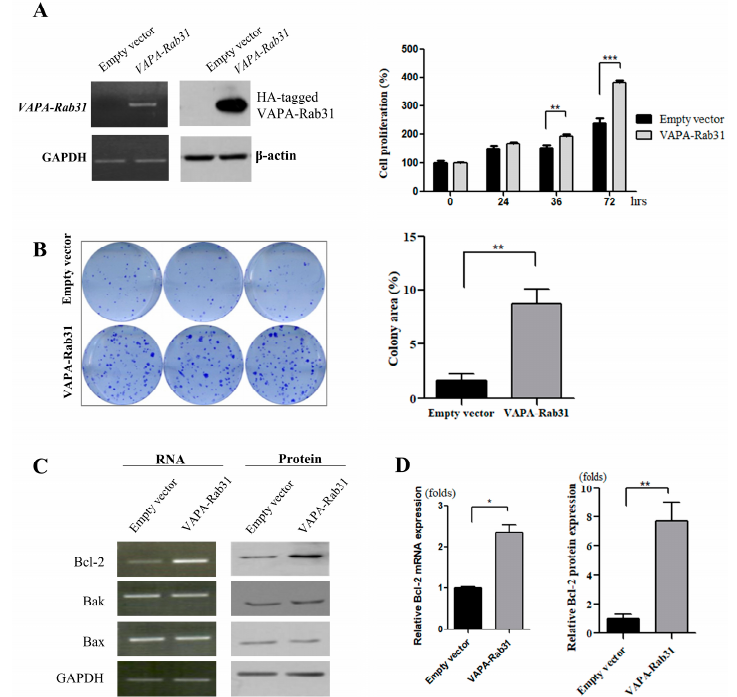
Figure 2. Overexpression of VAPA-Rab31 fusion increases proliferation, colony forming activity, and Bcl-2 expression. ( A ) Lentivirus-mediated overexpression of VAPA-RAb31 in Beas-2B cells was confirmed by RT-PCR and immunoblot assay detecting HA tag. Glyceraldehyde-3-phosphate dehydrogenase (GAPDH) and β -actin was used as control. Bar graphs indicated the relative cell numbers as the mean percentage (± standard error, SE) at the indicated time; the experiments were performed in triplicates. (** p < 0.01, *** p < 0.005) ( B ) VAPA-Rab31 -overexpressing cells and control cells were cultured to compare colony forming activity as demonstrated as representative data. Bar graphs compare the area of colonies that measured using ImageJ software. Data are expressed as means ± SE from three independent experiments and a significant result is marked with ** ( p value < 0.01). ( C ) Expression of Bcl-2, Bak and Bax were examined by RT-PCR and Western blotting. ( D ) The graph indicates the fold change of Bcl-2 expression relative to the expression in control cells. Statistical differences are marked with * ( p < 0.05), and ** ( p < 0.01), respectively. 2.3. VAPA-Rab31 Fusion Induces Resistance to Apoptosis To examine the effect of VAPA-Rab31 on apoptosis, the apoptotic markers were compared after induction of apoptosis through bortezomib treatment. Cell cycle analysis revealed that the proportion of sub-G1 phase cells was smaller in the VAPA-Rab31 -overexpressing cells than in the control cells (Figure 3A). The cleaved PARP and active Caspase-3 were strongly induced in the control cells after bortezomib treatment. However, the cleavage of PARP and the active form of Caspase-3 in VAPA-Rab31-overexpressing cells was not induced as much as the control cells after bortezomib treatment indicating reduced apoptosis (Figure 3B). The levels of relevant proteins and their phosphorylation were examined in cytosol, nucleus and whole cells. In VAPA-Rab3 -expressing cells, Bcl-2 protein and phosphorylated CREB at serine 133 (p-CREB) were retained upregulation even after bortezomib treatment. Phosphorylated Erk (Thr202/Tyr204) was also increased in the nuclear fraction of VAPA-Rab31 -expressing cells (Figure 3C).